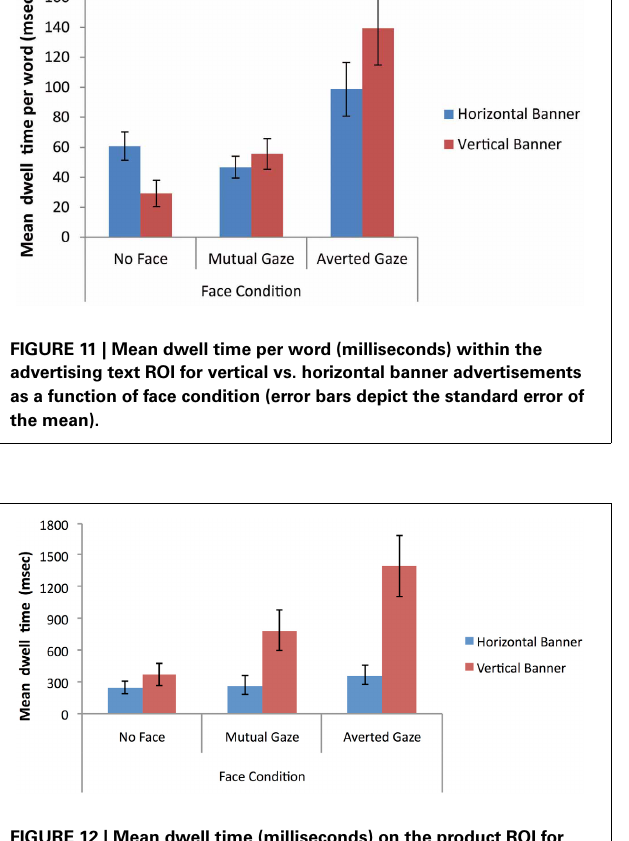
FIGURE 10 | Mean dwell time (milliseconds) on the face ROI for vertical vs. horizontal banner advertisements as a function of face condition (error bars depict the standard error of the mean).